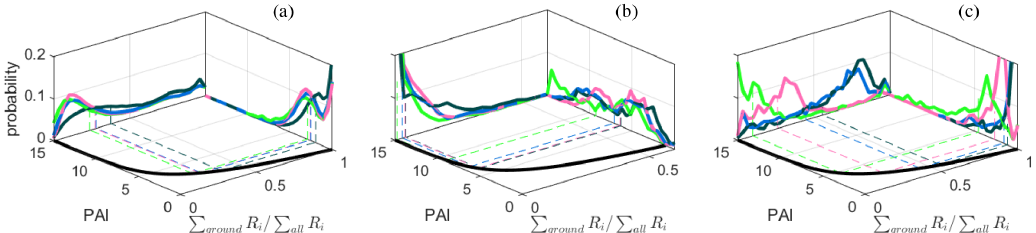
Figure 6. The mapping of PAI from the ratio of ground returns to the total number of returns ( (cid:80) ground R i / (cid:80) all R i at a 10m × 10m resolution) using Eq. (9) (black line in the x – y plane). The vertical axis shows the respective distributions of the PAI ( y – z plane) and (cid:80) ground R i / (cid:80) all R i ( x – z plane), at a 10m × 10m resolution, for the four methods (SR is represented using blue, IR is represented using dark green, FR is represented using light green, and AR is represented using pink). The dashed lines indicate the area-averaged PAI from averaging the PAI at a 10m × 10m resolution for the Norunda (a) , Falster summer (b) , and Falster winter (c)